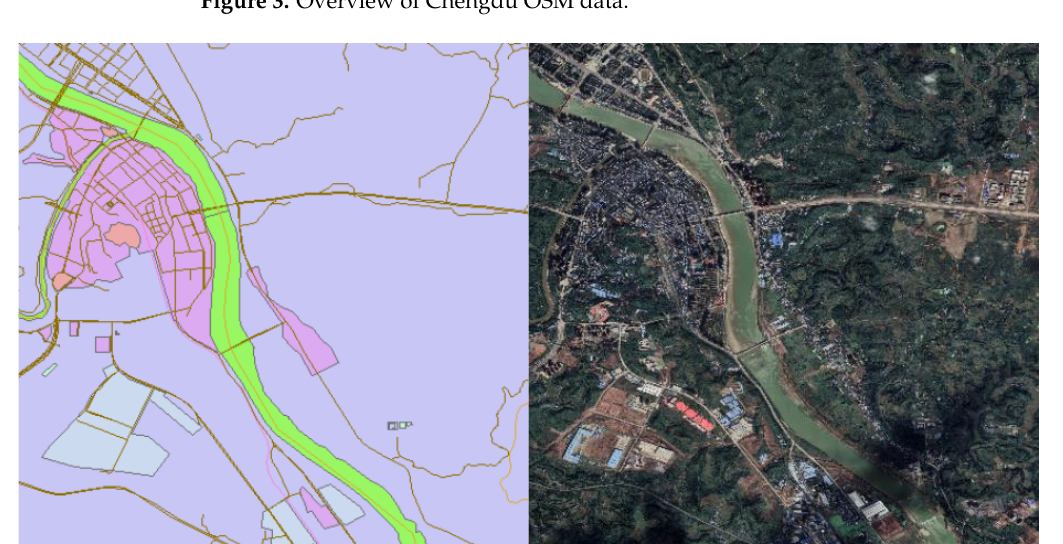
Figure 4. Example mapping of the OSM and high-resolution image.